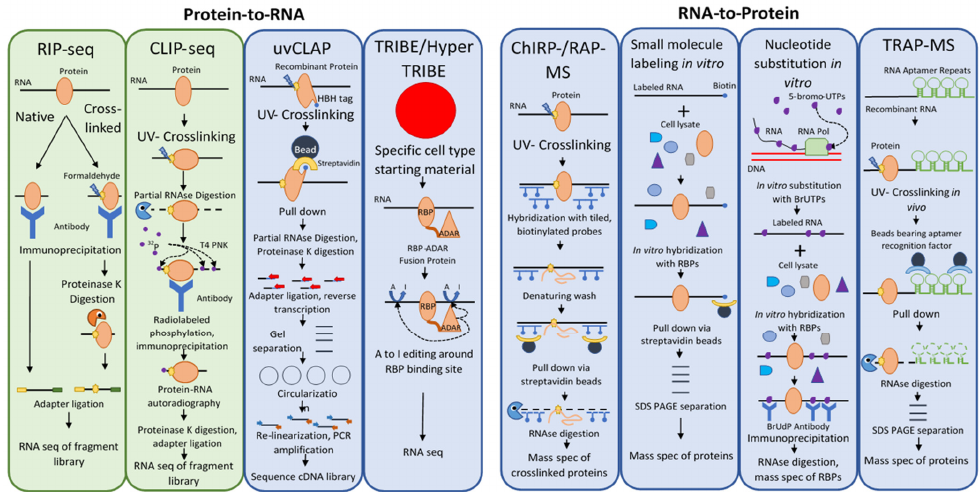
Figure 1. Methods to Detect RNA-Protein Interactions Using RNA or Protein Bait. Diagrammatic representation of the major steps in these notable methods. A green background denotes that the technique has been used in plants, whereas a blue background indicates that the technique has thus far only been used in mammals or other organisms. Crosslinking and immunoprecipitation (CLIP) derivatives are not detailed here but have been recently reviewed [14].